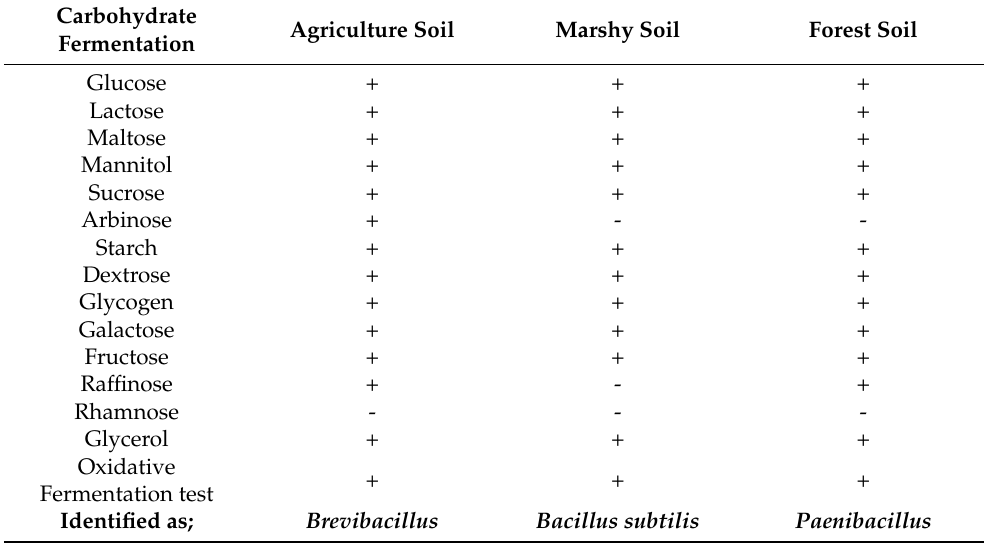
Table 3. Different Carbohydrate fermentation of bacterial Isolates from Agricultural, Marshy, and Forest